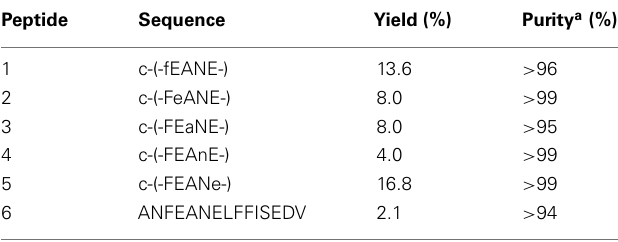
Table 2 | Characteristics of synthesized CagL